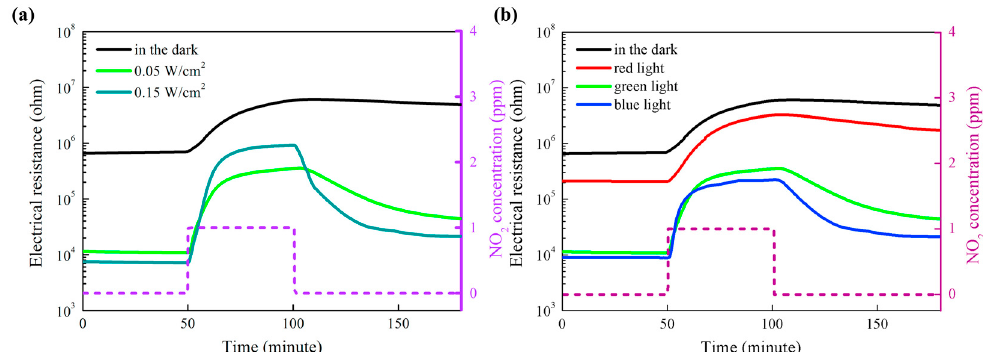
30 of 53 Figure 48. ( a ) UV-vis diffuse reflectance spectra; ( b ) photocurrent of ZnO, CdS NPs and the CdS NPs/ZnO A, B, C and D (A, B, C and D: mass ratios of CdS/ZnO were 0.063:1, 0.079:1, 0.100:1 and 0.330:1, respectively); ( c ) Formaldehyde sensing response under visible light illumination of CdS and CdS NPs/ZnO C. Reproduced with permission from [10]. There are also reports on the use of heterostructures for sensing oxidizing gases [73,74]. Geng fabricated porous CdS-ZnO for sensing NO 2 at room temperature with light illumination at different wavelengths. They showed that the CdS worked as a sensitizer which enabled visible light activation. They also studied the relationship between sensing response and light intensity, light wavelength and material structure (Figure 49). The sensing response of CdS-ZnO to NO 2 was enhanced with green light illumination and further increase by increasing the light intensity (Figure 49a). The sensing speed was also accelerated by increasing light intensity. The NO 2 sensing properties were also compared under light with different wavelengths while maintaining power constant and green light produced the highest sensing response, which was consistent with the light absorption spectrum of the sample (Figure 49b). The CdS-ZnO exhibited higher response to NO 2 than pure ZnO under green light illumination and further increase in sensing response was achieved by introducing more pores in the CdS-ZnO composite. The mechanism of gas sensing in dark and with light illumination was attributed to the widely accepted surface depletion model. Three factors were influencing the gas sensing properties: carrier concentration, depletion region width and grain boundary barrier height. The improved sensing performance from CdS-ZnO heterostructures were associated with both the CdS sensitization and the electron injection from CdS to ZnO, which suppressed the recombination of photogenerated electron-hole pairs and lengthened electron lifetime (Figure 50) [73]. Hoffmann also fabricated CdS-ZnO on Si substrate for sensing of various gases including both oxidative and reducing gases at room temperature with solar light adsorption. Though this gas sensor was based on measurement of voltage change, which was different from conductometric case, its